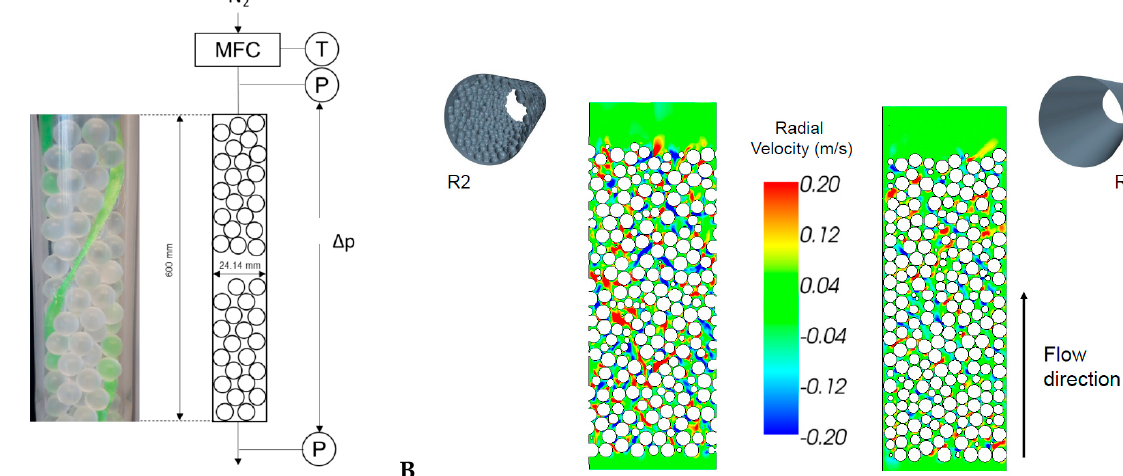
Figure 2. ( A ) Packed bed reactors filled with heat fins [2]. ( B ) Comparison of the local radial velocity between configuration R2 with wall structure and R7 for a D / d p -ratio of 8.8 [3].